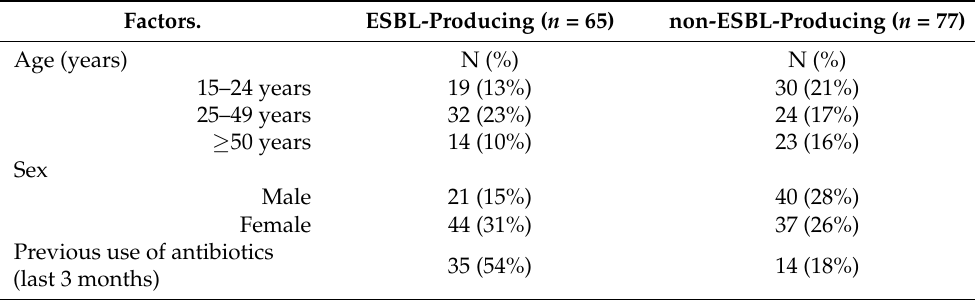
Table 1. Characteristics of urinary Enterobacterales studied according to their production of ESBL or not.